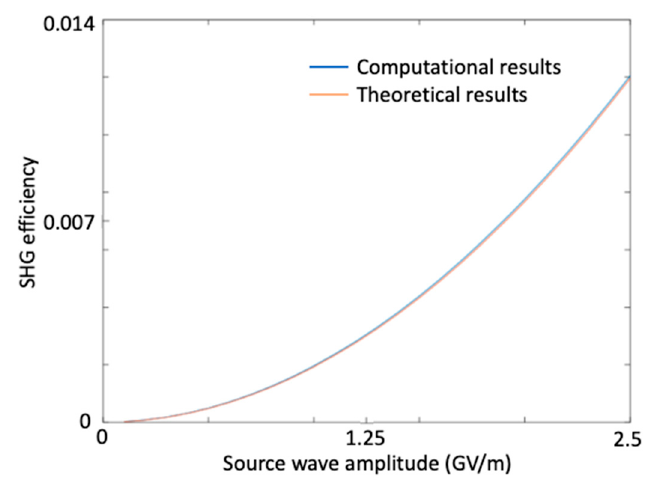
Figure 12. Comparison of the theoretical and the computational second harmonic generation e ffi ciencies for f input = 100 THz and d = 1.21 × 10 − 21 C / V, versus the source wave amplitude.